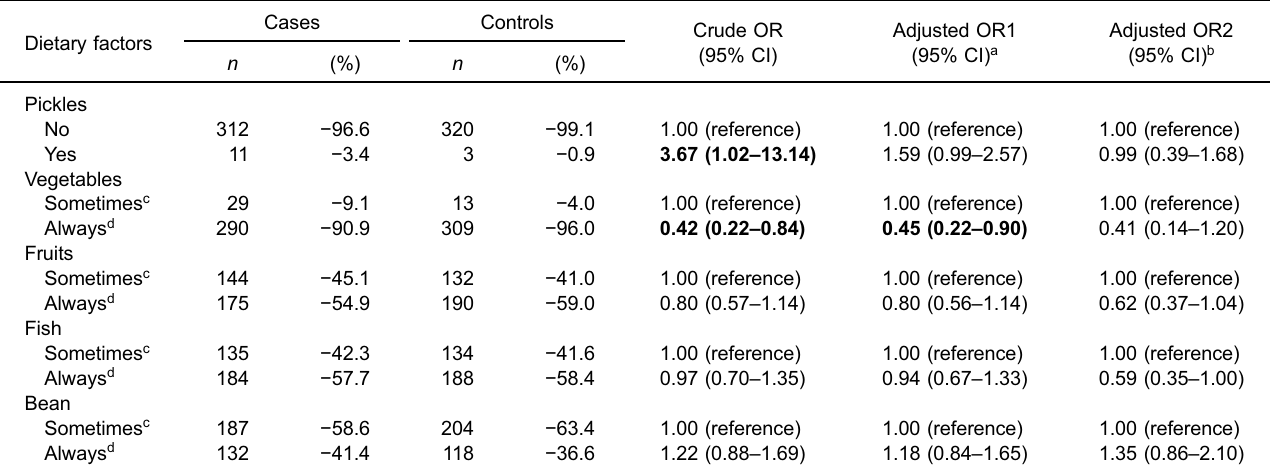
Table 4. Dietary factors associated with risk of pancreatic cancer Dietary